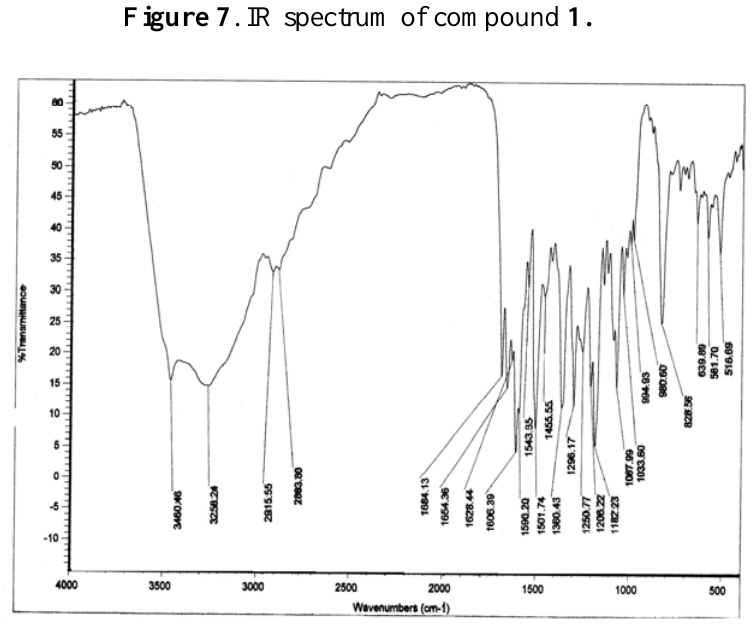
Figure 7 . IR spectrum of compound 1.